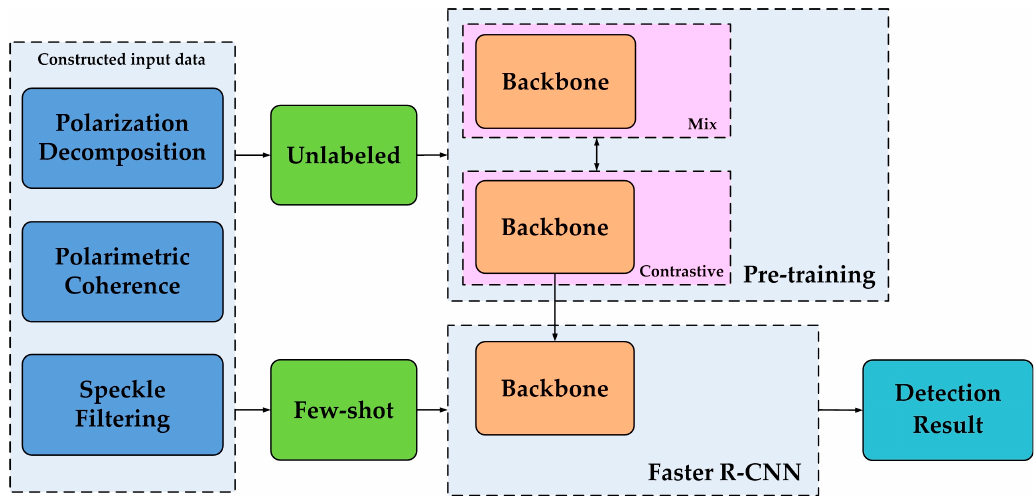
Figure 1. Overall framework of the proposed